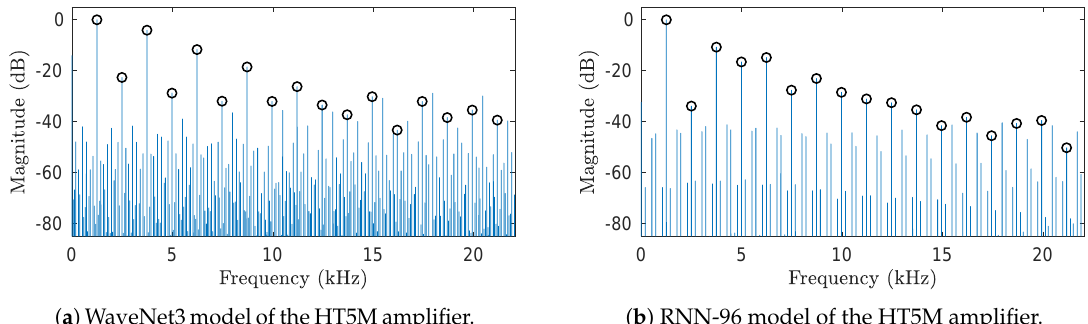
Figure 17. Spectra of a 1245-Hz sinusoid fed through the WaveNet3 and RNN-96 models, the black circles indicate the non-aliased